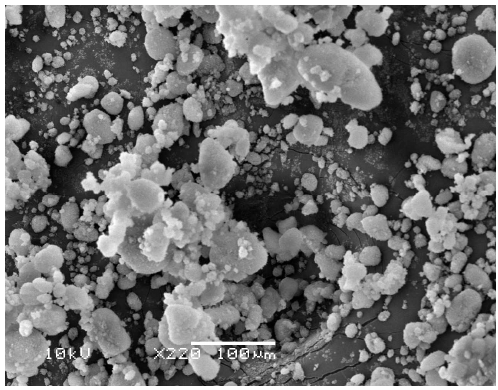
Figure 3. SEM image showing different levels of agglomeration of the nanopowder.